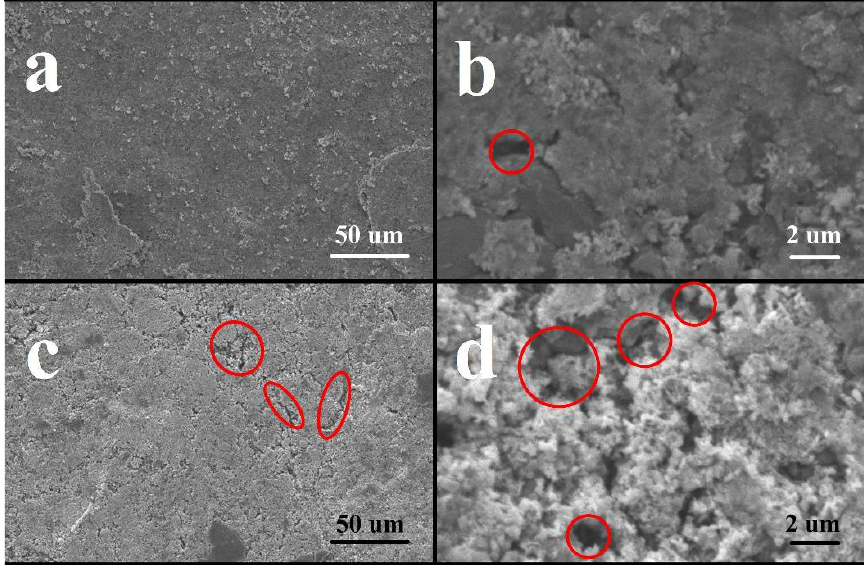
Figure 5. SEM results of the surface of B(11%)/NC/CuO thermite device via ( a , b ) electrospray and ( c , d ) ball milling.